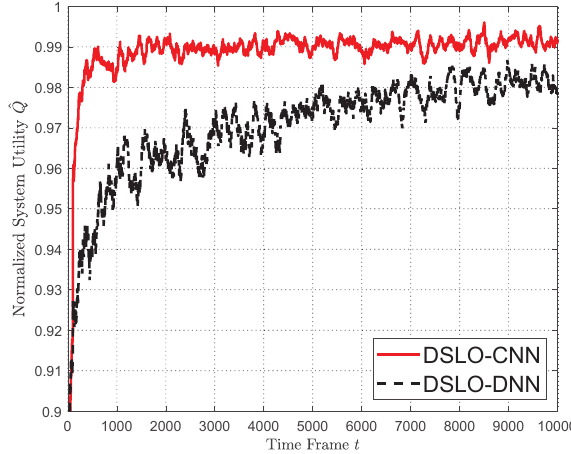
Figure 9. DSLO with |K train | = 2 per MEC scenario.